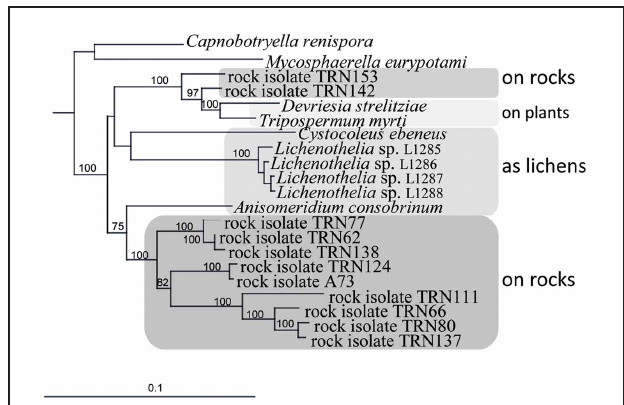
FIGURE 2 | Close relationships of life styles in a subgroup of the Teratosphaeriaceae (Dothideomycetes), including rock-inhabiting black fungi, lichens, and plant-surface colonizers. Bayesian analysis of combined nuSSU, nuLSU, and mtSSU